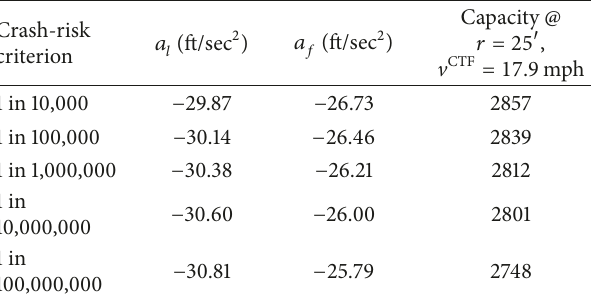
Table 2: Sensitivity analysis of rates of deceleration of leading and following vehicle (weak ACDA